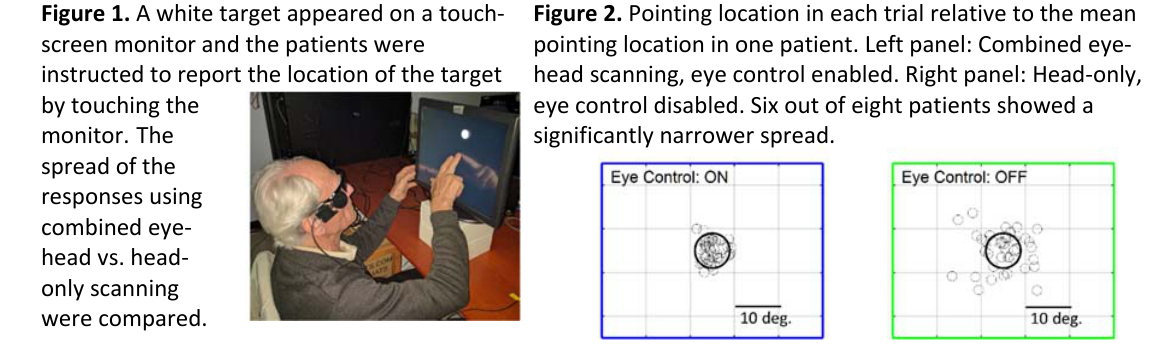
Figure 2. Pointing location in each trial relative to the mean pointing location in one patient. Left panel: Combined eye‐ head scanning, eye control enabled. Right panel: Head‐only, eye control disabled. Six out of eight patients showed a significantly narrower